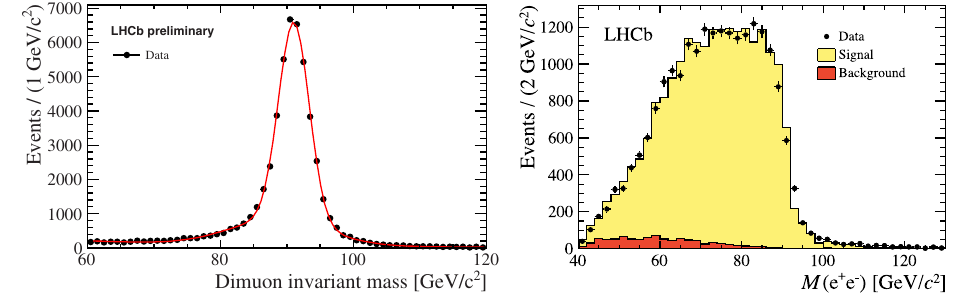
Figure 1. Di-lepton invariant mass distribution for the Z → (cid:2)(cid:2) (left) and Z → ee (right) final states.